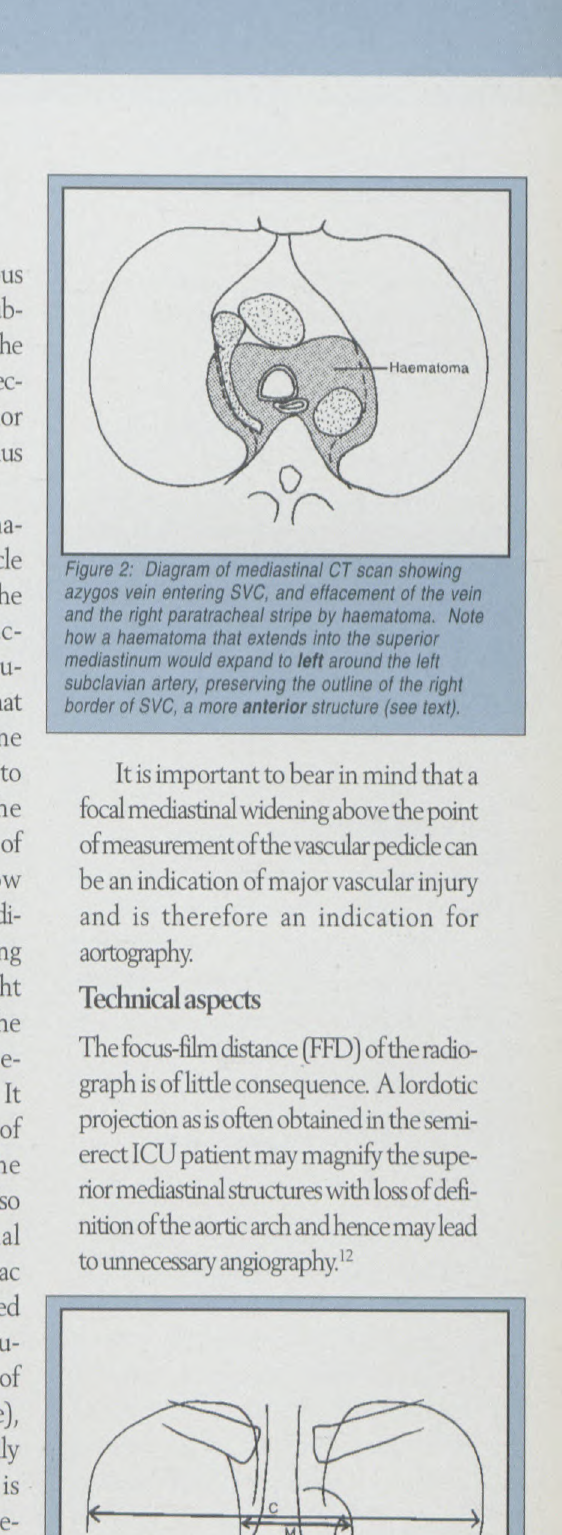
Figure 1.' Diagram of mediastinal structures seen on a supine chest radiograph to show method of transverse width measurement (ML+MR) (see text).